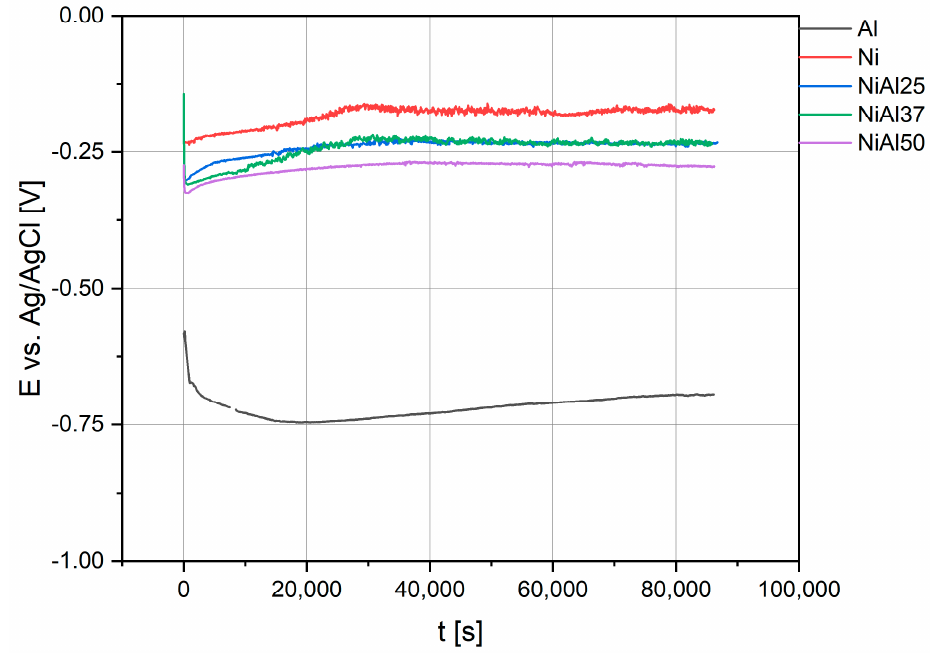
Figure 6. Open circuit potential of samples measured in 0.1 M H 2 SO 4 .